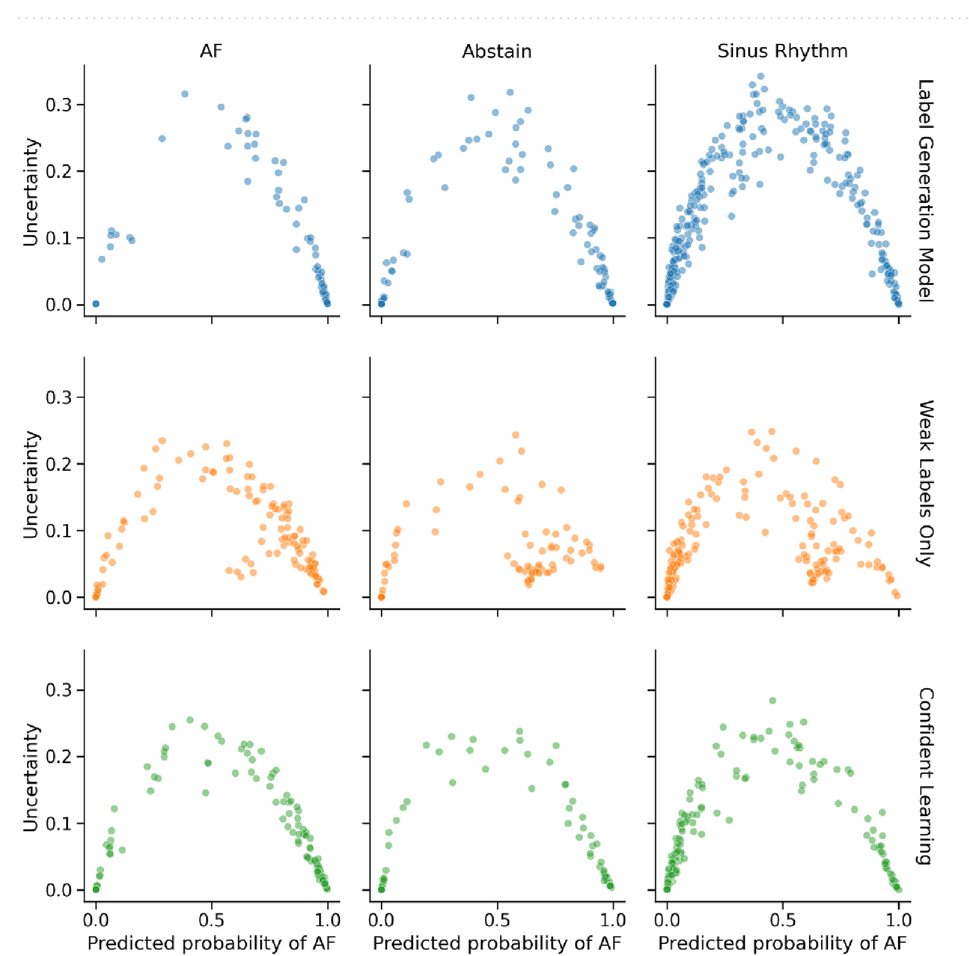
Figure 8. Comparison of model uncertainty versus confidence on in-distribution classes (AF, sinus rhythm) and out of distribution class (Abstain) when using both aleatoric and epistemic uncertainty estimation. All models show an association between high uncertainty and low confidence (i.e. neither definitively the AF nor the sinus rhythm classes). Compared to training with weak labels directly, Confident Learning avoids assigning low uncertainties to more non-confident samples that generally lean towards the AF